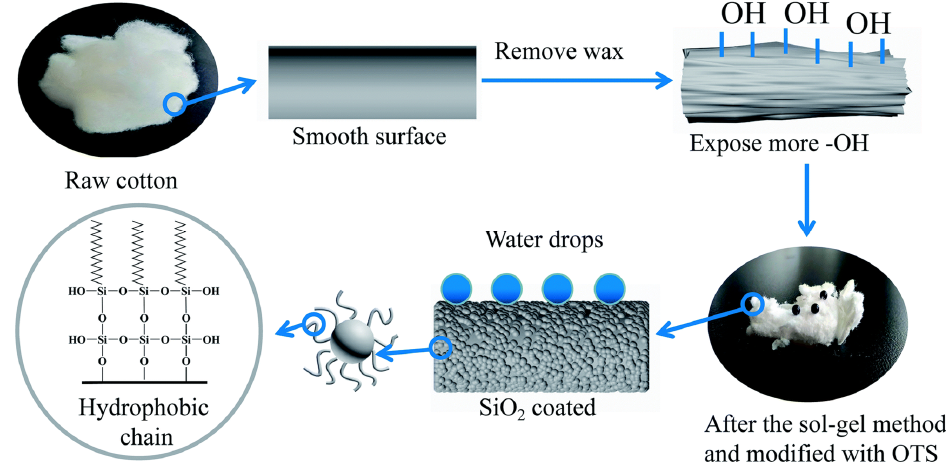
Figure 17. Schematic illustration of the modification cotton fiber (Reproduced from [139], under Creative Commons Attribution 3.0 International